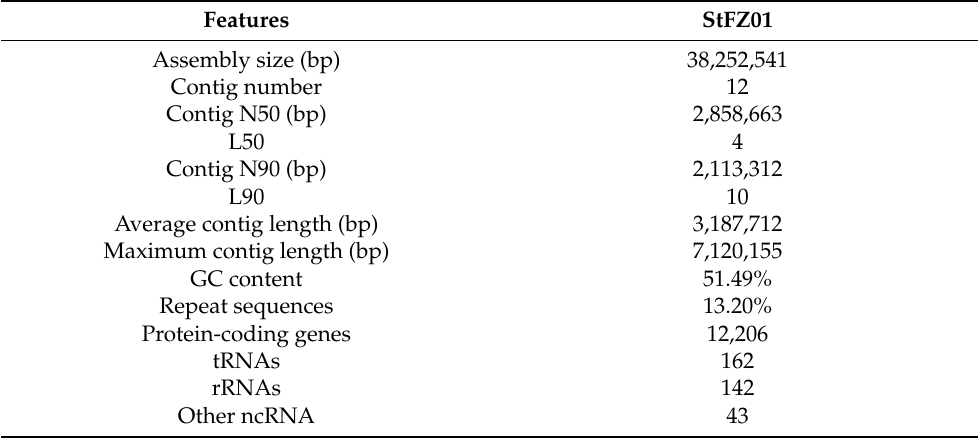
Figure 3. Genome features of Stagonospora tainanensis strain StFZ01. ( A ) Summary of ONT reads. ( B ) Genome size estimation with NGS genomic reads; ( C ) Circos plot of genome assembly features. Circles from outside to inside present contigs (1st circle, the smallest contig ctg12 was not shown), distribution of protein-coding genes (2nd), TEs (3rd), and putative secreted proteins (4rd) per 50 kb window size (color blue to red means number from low to high). The lines in the center of circle show the synteny blocks (≥10 kb) between different contigs. Table 1. Genome Assembly Features of Stagonospora Tainanensis Strain StFZ01.